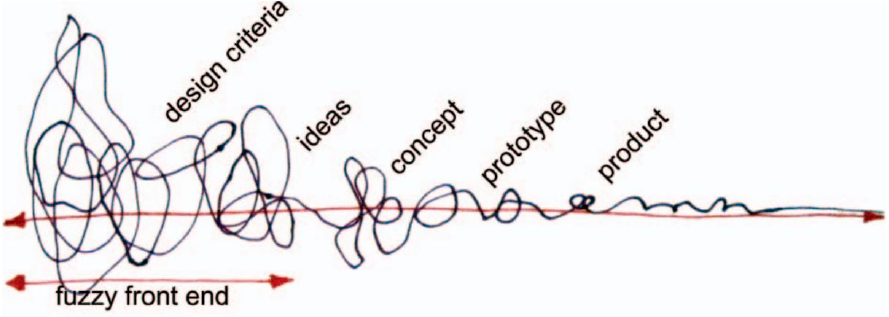
Figure 1. The fuzzy front end is characterized by ambiguity and uncertainty [15]. Reprinted with permission of the publisher (Taylor & Francis Ltd., http://www.tandfonline.com).